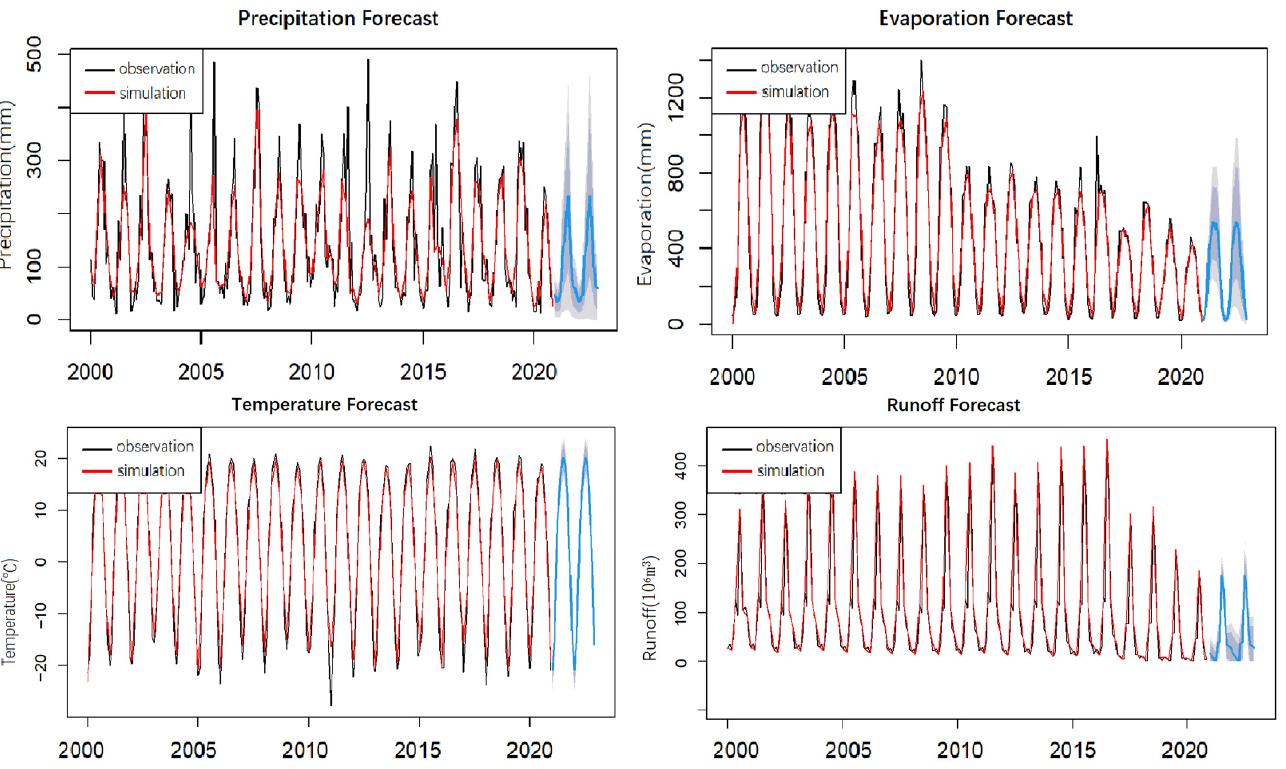
Figure 4. Monthly data forecast for four hydrological parameters using EnKF.